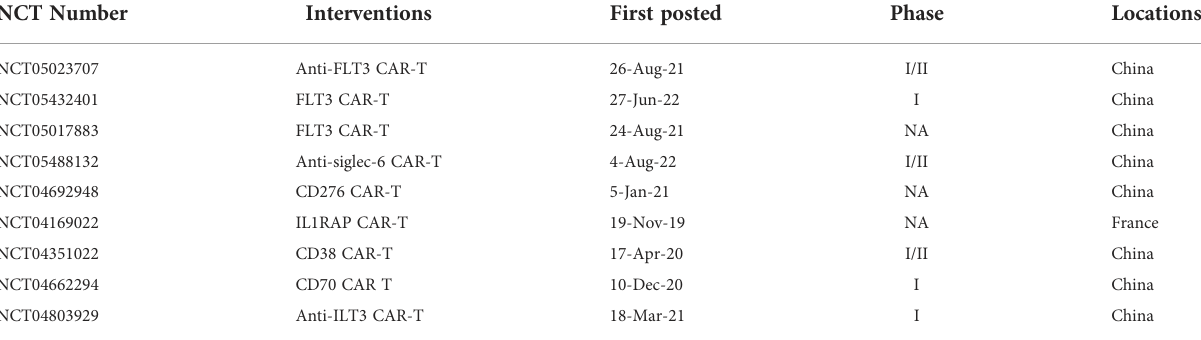
TABLE 8 Recruiting other CAR clinical trials for